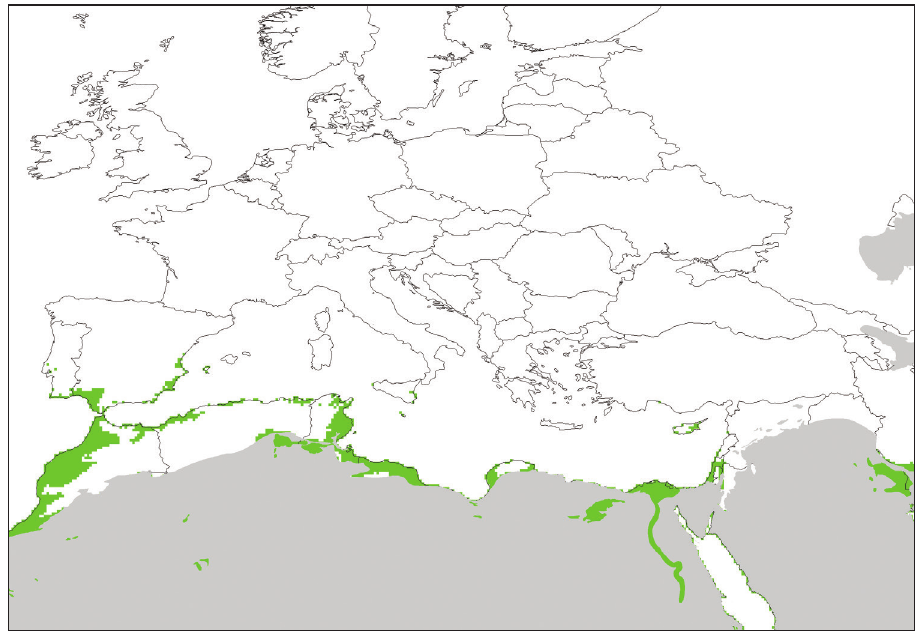
Figure 2. Non-desert areas of the EPPO region that are climatically suitable for T. leucotreta. This map is based on the relationship between maximum and minimum temperatures in the coldest month (July for the southern hemisphere and January for the northern hemisphere) based on: Tmin >= 1°C and Tmax >= 18°C, or Tmin >= 3°C and Tmax >=